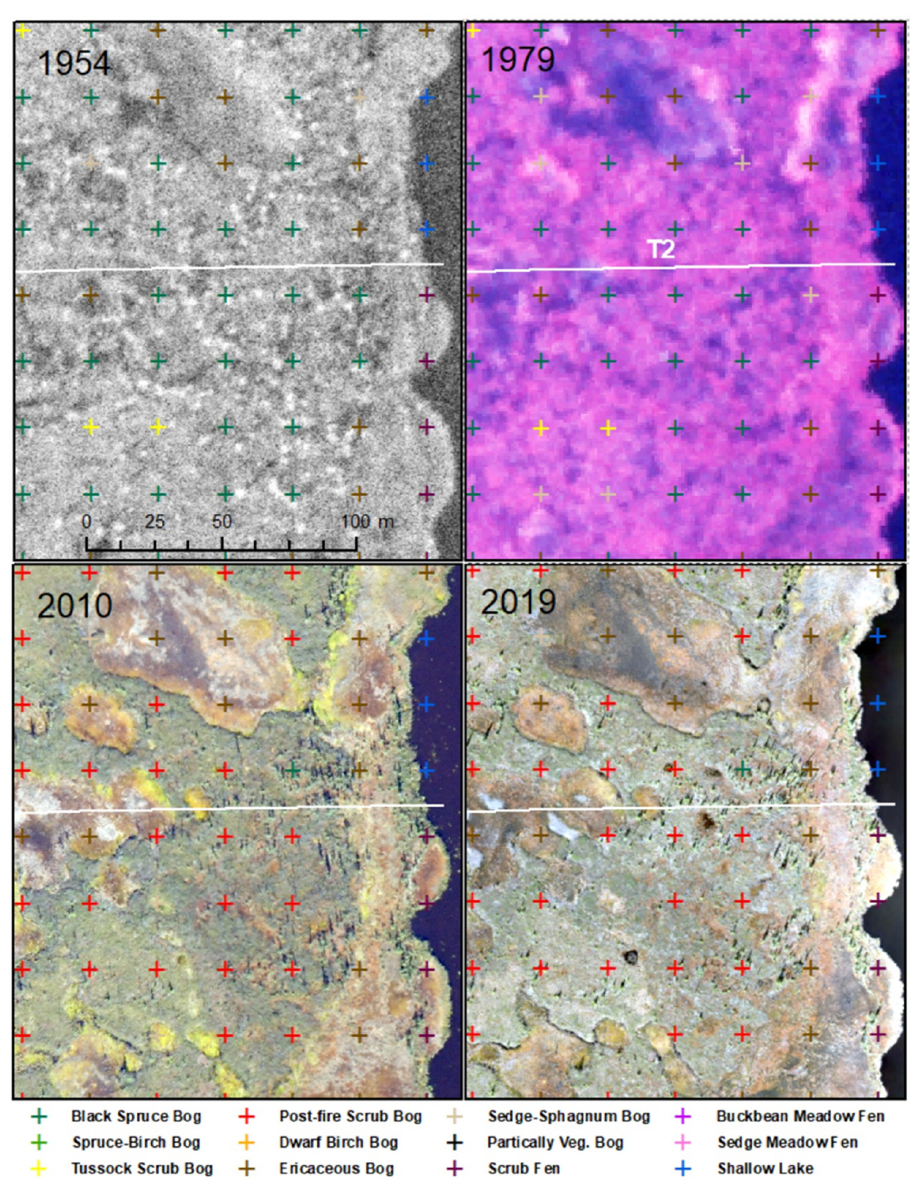
Figure 3. Enlarged portion of Grid 2 showing ecotype changes at the grid point across a time series of imagery from 1954 to 2019. Sampling points are colored by ecotype. The white line shows Transect 2.